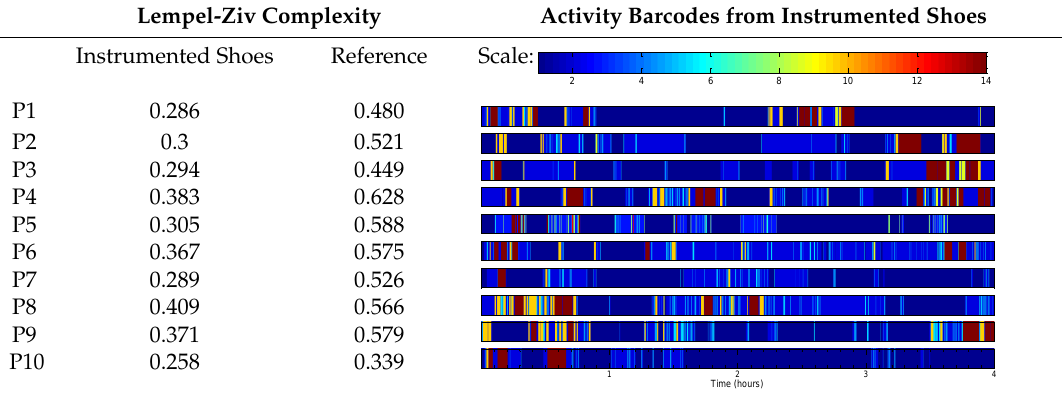
Sensors 2016 , 16 , x FOR PEER 12 of 18 Table 5. Subject specific activity barcodes. The scale on the right indicates the activity intensity, starting from 1: sitting, 2: standing, 3–14: walking with different cadences and locomotion period durations. Lempel-Ziv complexity values for each subject and for each activity monitoring system are shown. Lempel-Ziv Complexity Activity Barcodes from Instrumented Shoes Instrumented Shoes Reference Scale: P1 0.286 0.480